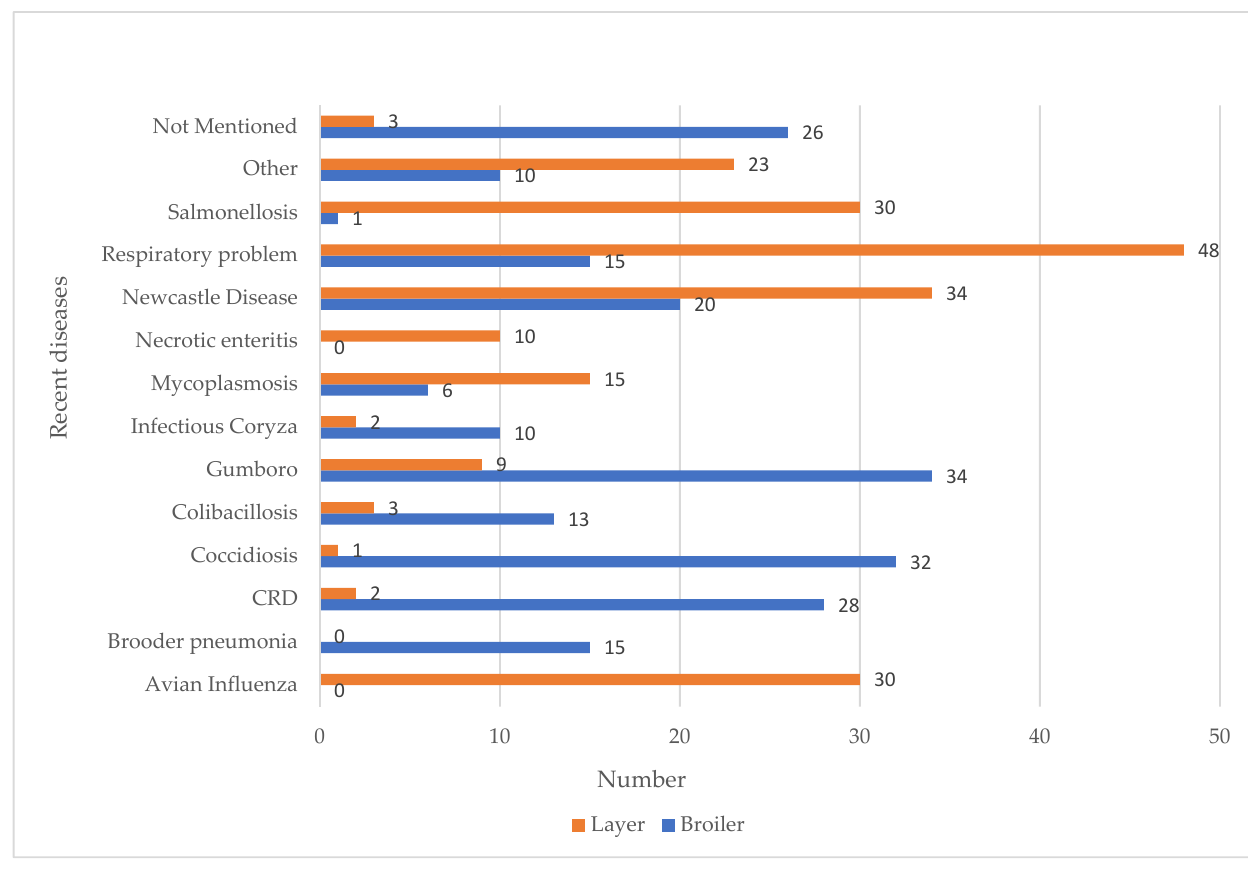
Figure 1. Incidence of diseases on broiler and layer farms.